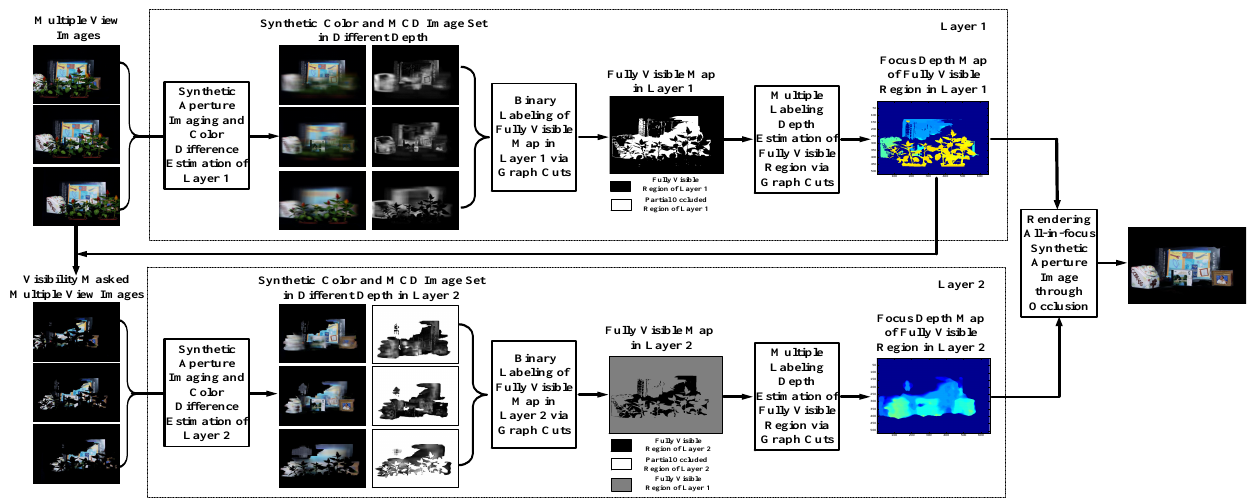
Figure 3. Framework of our active synthetic aperture imaging algorithm. MCD, maximal color